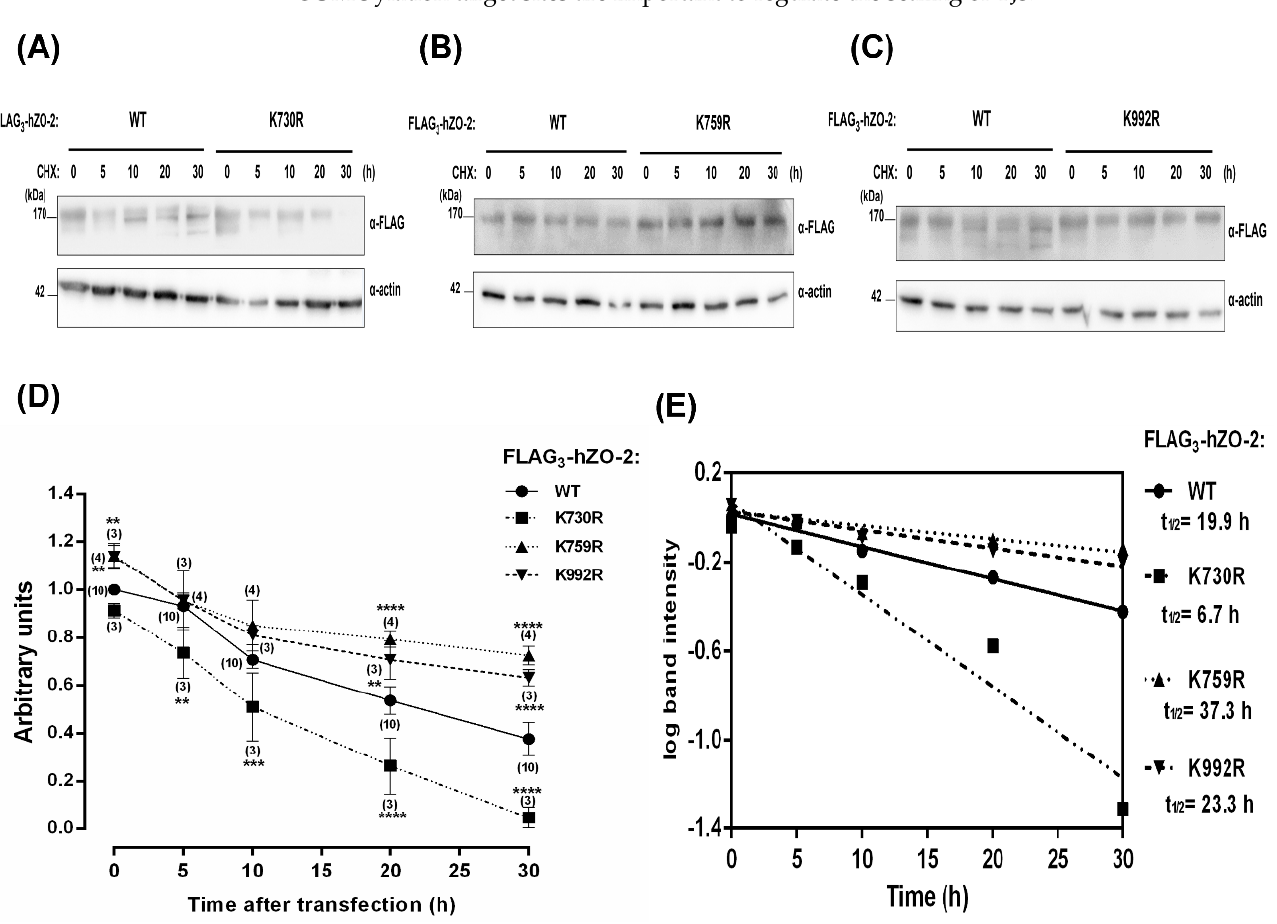
Figure 4. The stability of hZO-2 is regulated by K48 poly-ubiquitination sites K759 and K992 and by the SUMOylation site K730. MDCK cells were transfected with Flag 3 -hZO-2 WT, the ubiquitination mutants FLAG 3 -hZO-2 K759R and K992R, or the SUMOylation mutant FLAG 3 -hZO-2 K730R. After 6 h, protein synthesis was blocked with 30 μM cycloheximide for the indicated times (h). ( A – C ) Representative images of cell lysates analyzed on Western blots with antibodies against FLAG or actin, latter used as a loading control. ( D ) Quantitative analysis of Western blots derived from three independent experiments. Statistical analysis was done with a Two-way ANOVA followed by Bonferroni ’ s test. ** p < 0.01, *** p < 0.001,